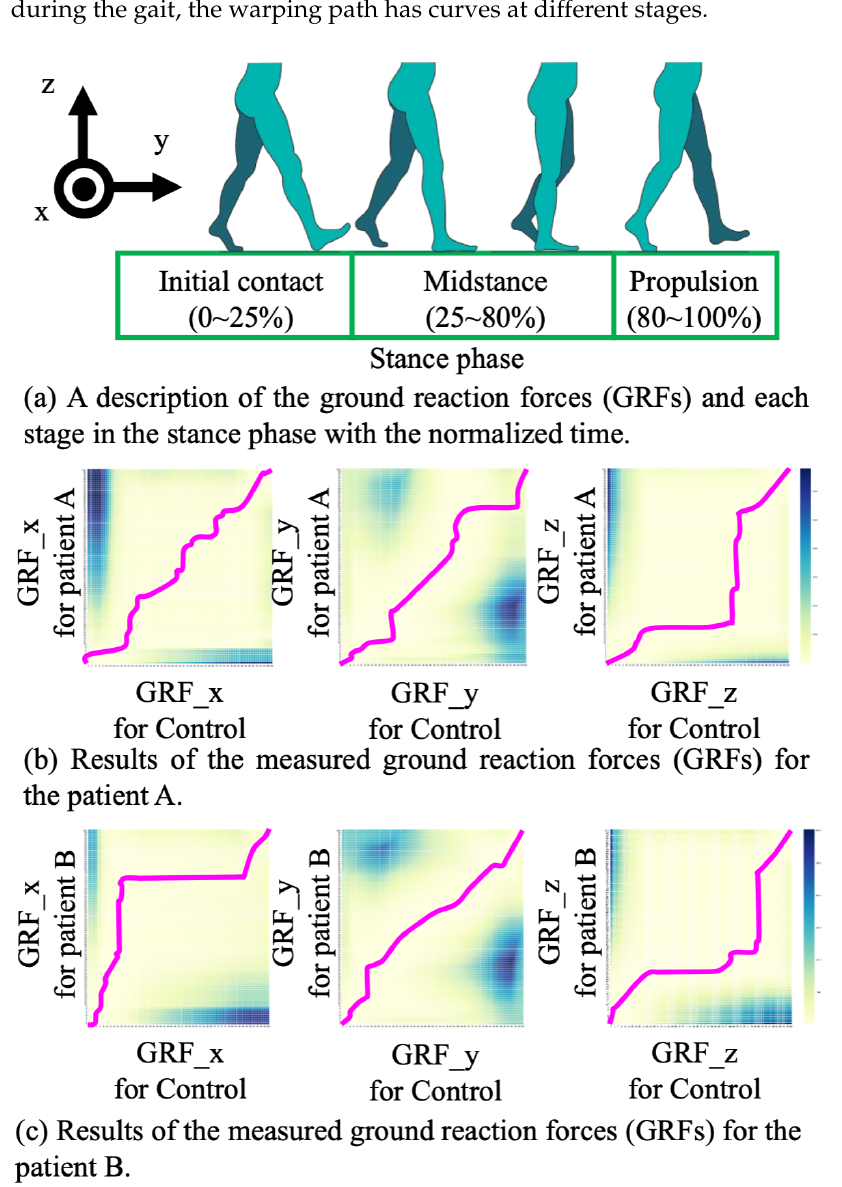
Figure 6. Results of accumulated cost matrices for patient A ( b ) and patient B ( c ) and the warping path, which is expressed as pink-colored curves for each